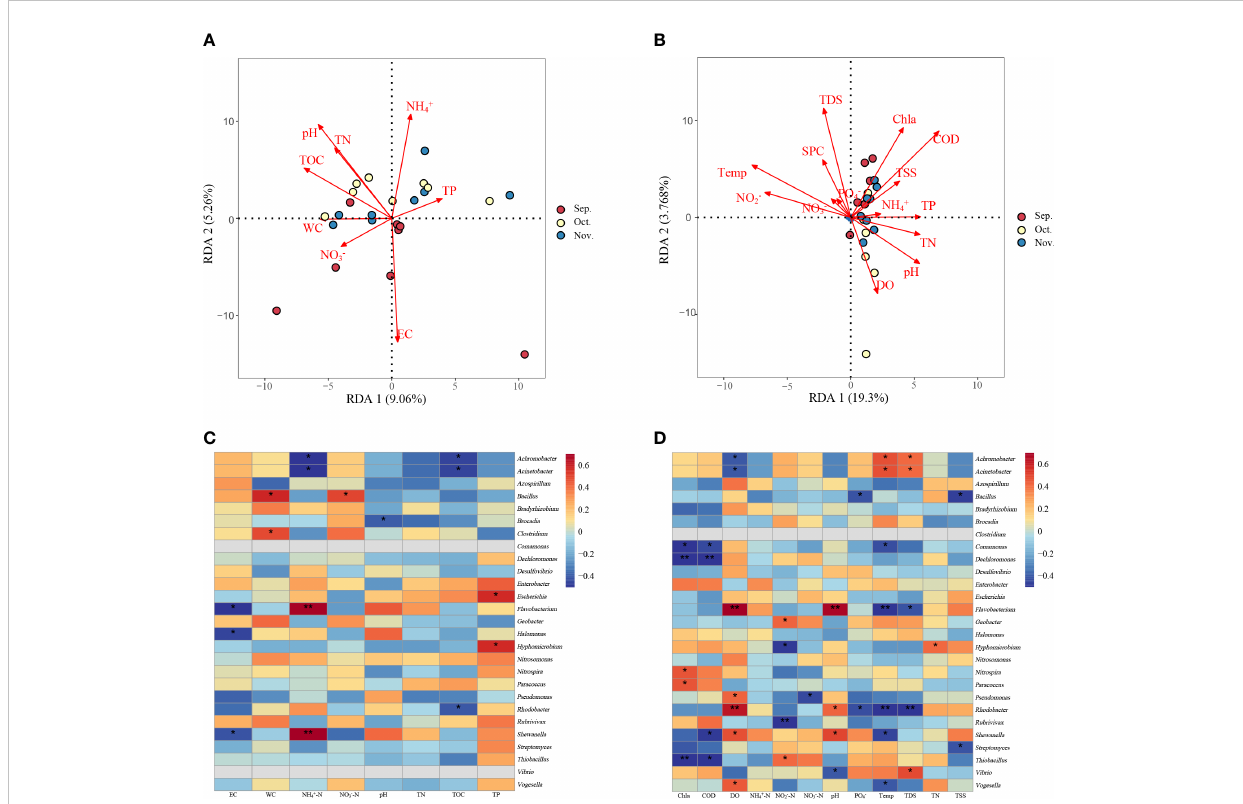
FIGURE 6 Redundancy analysis (RDA) shows the relationships between the community composition and physicochemical properties of sediment (A) or water (B) determined in the zero – water exchange ponds. Correlation analyses between physicochemical properties and functional genera associated with nitrogen cycling found in the microbial communities from the sediment samples (C) and water (D) . The color intensity shows the R-value of correlation in each panel, and the asterisk represents signi fi cant correlations at P < 0.05 level. TN, total nitrogen; TP, total phosphorus; DO, dissolved oxygen; Temp, temperature; TDS, total dissolved solids; COD, chemical oxygen demand; TOC, total organic carbon; TSS, Total suspended solids; EC, electric conductivity; WC, water content; Chl a, Chlorophyll a; SPC, speci fi c conductance. * P < 0.05; ** P <